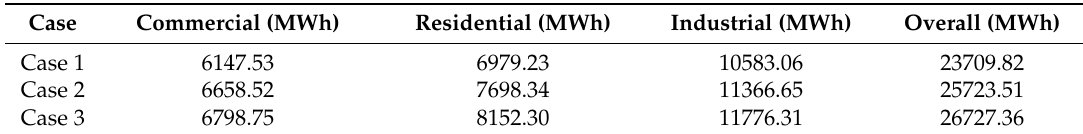
Table 4. Total daily load.